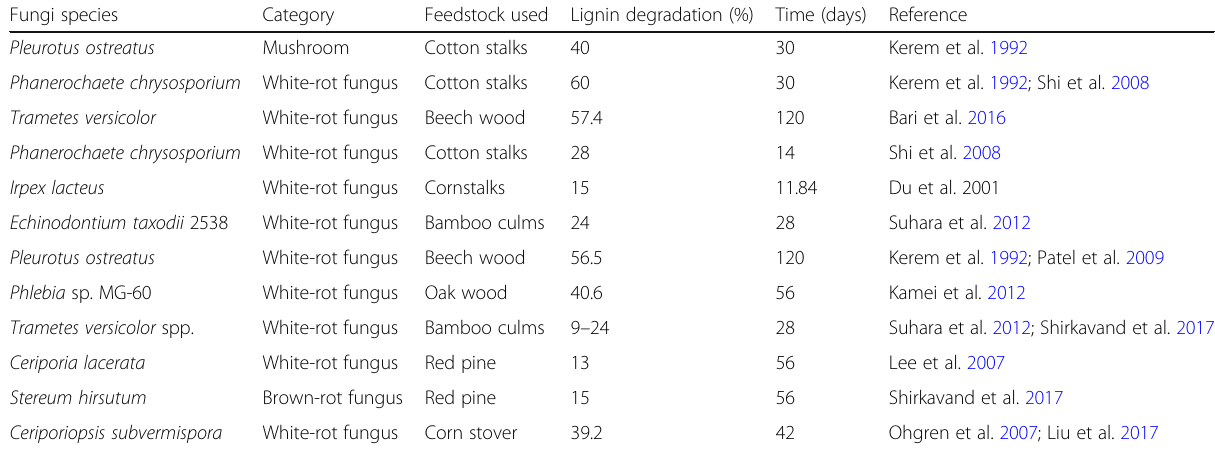
Table 3 Fungi degradation of lignin on different feedstock Fungi